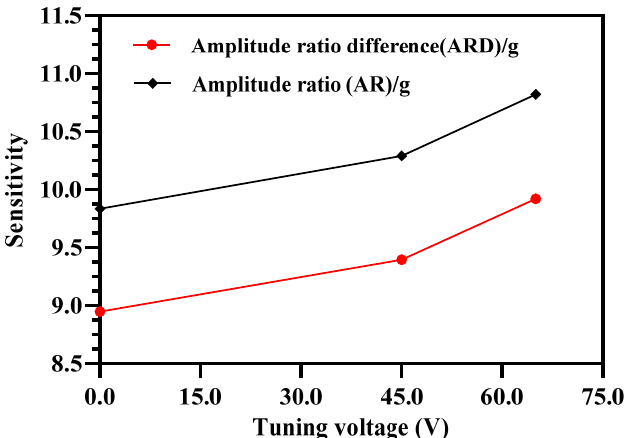
Figure 11. Effect of applying electrostatic tuning voltage on the outer and inner resonators (in Set A and Set B) on the amplitude ratio and amplitude ratio difference sensitivity.